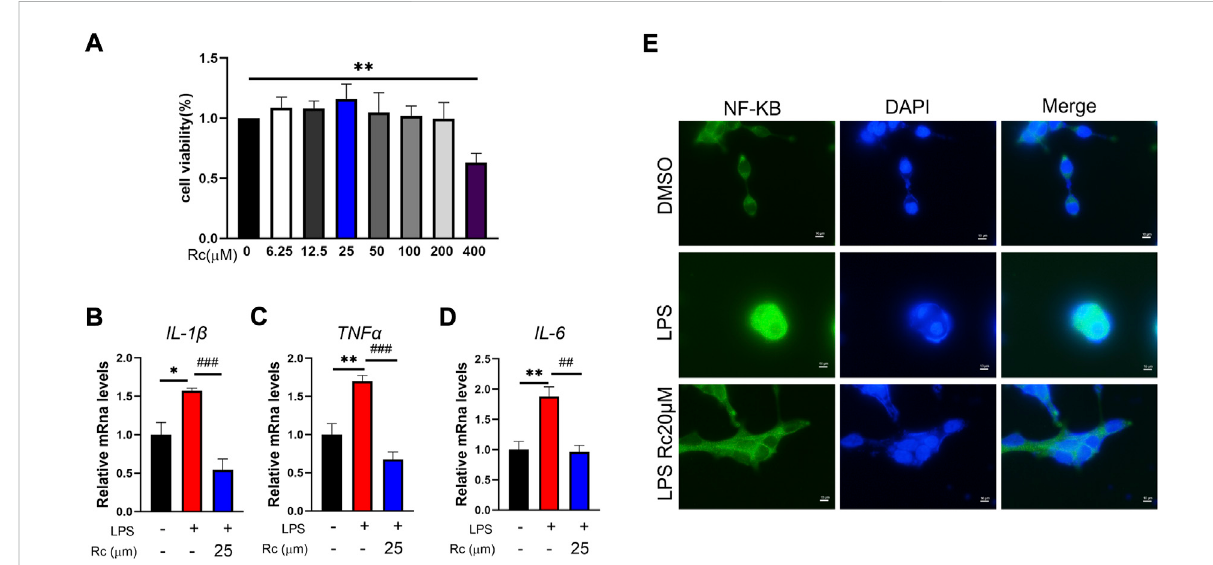
FIGURE 1 Rc attenuated in fl ammatory in LPS-induced LS174 cells. Cell viability (A) of Rc in LS174 cells ( n = 3); after incubation with Rc and LPS following the protocol, the cells were collected for qPCR analysis, and the relative mRNA levels of IL-1 β , TNF- α and IL-6 (B – D) were measured ( n = 4); representative images of immuno fl uorescence of NF- κ B (E) . Data are shown as the mean ± SEM. * p < 0.05, ** p < 0.01, *** p < 0.001 vs . the DMSO group.